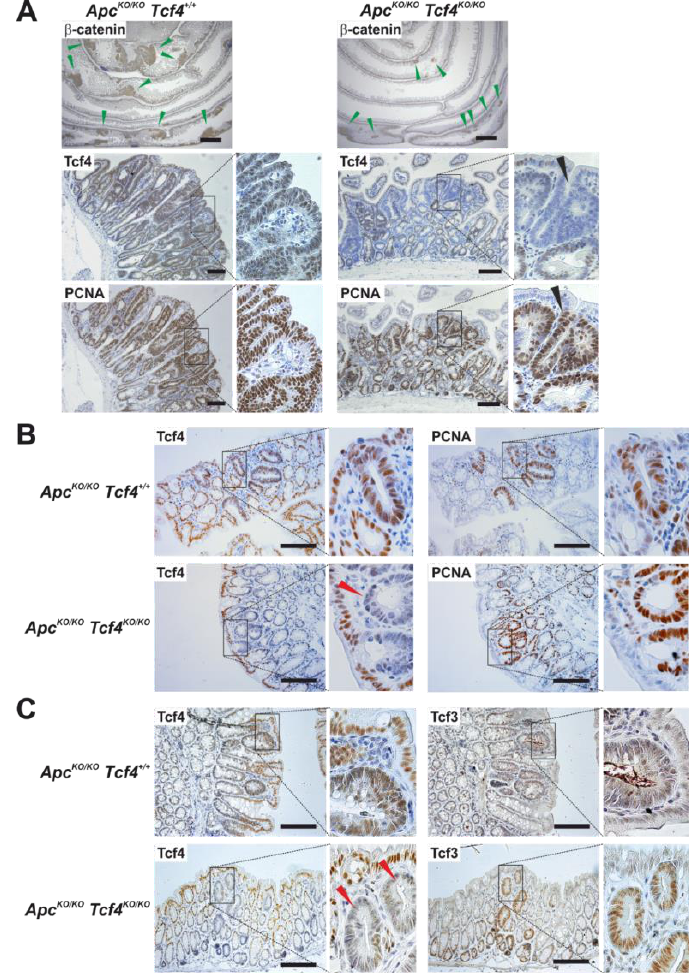
Figure 5. Tcf4 inactivation reduces tumor formation in the small intestine. Immunohistochemical staining of the small intestinal ( A ) and colon ( B ) tumors generated in Apc flox14/flox14 Tcf4 +/+ Lgr5-CreERT2